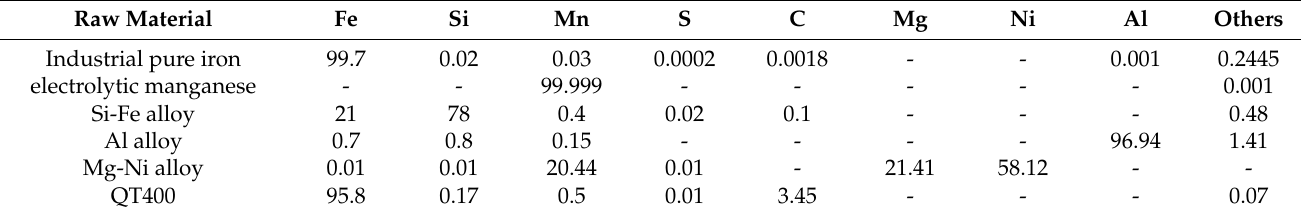
Table 1. Raw material composition (mass/%).